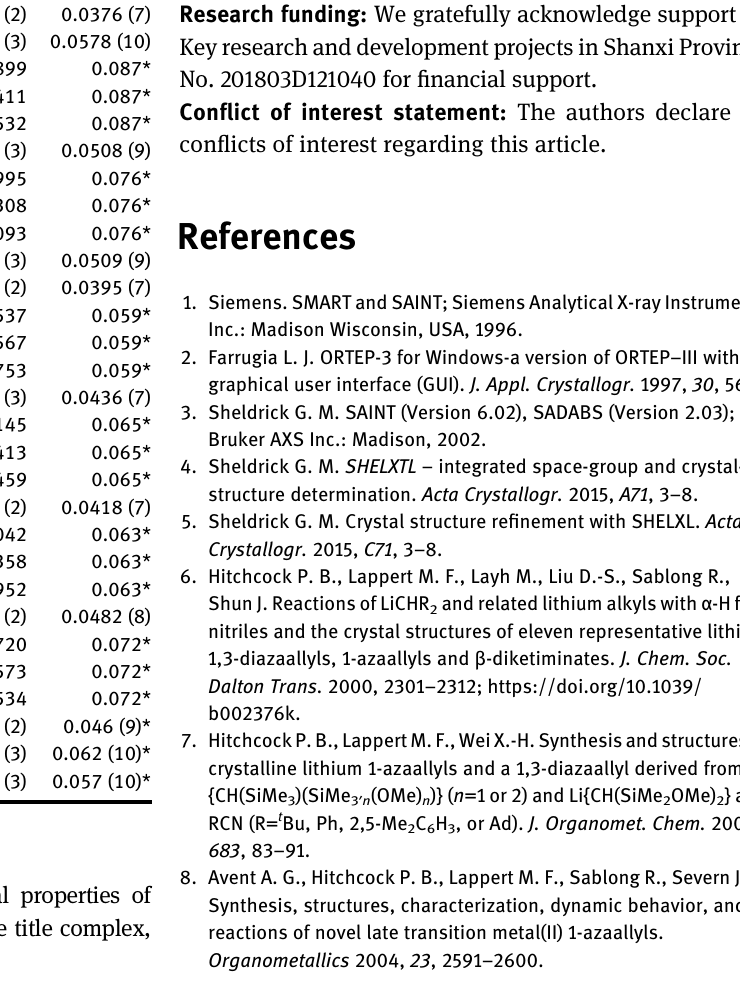
The title compound is a centrosymmetric dimer which contains two NSiN fragments bonded to two central Li atoms. Thus it is a good spectator ligand to study its conjugation and chemical properties. The two amidinate li- gands bound to two Li atoms, with Li – N bond lengths 2.081(5), 2.114(5) and 2.036(5) Å. The central Li atoms are part of three planes: two crystallographically identical four- membered planes (N1/Si1/N2/Li1 with RMS devia- tion = 0.0111 Å) and one central four-membered ring (N/Li with symmetry). The former plane encloses an angle of 45.7(3) ° with the latter plane. And these three planes form a cascade-step con fi guration. Each lithium atom is surrounded by three nitrogen atoms. Some slightly different Li complexes have been found with similar con fi guration which have similar manner bonded to central Li atoms [8, 12, 14, 16].